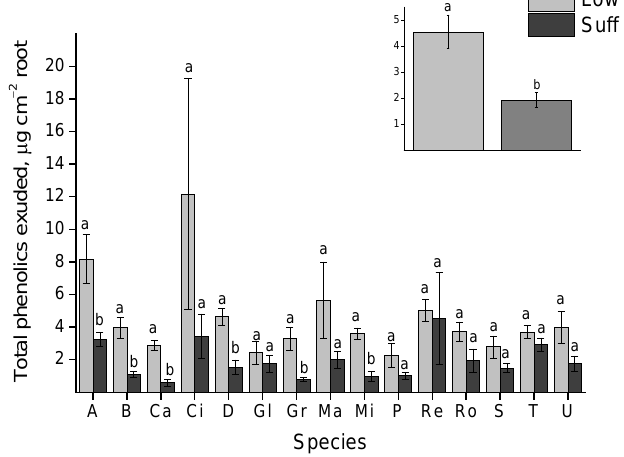
Figure 5. Total phenolics exuded by the roots of fifteen eucalypt species grown under low (Low P, clear color) and sufficient (Suff P, dark color) phosphorus concentrations. Different letters indicate significant differences between low and sufficient P concentrations within each species by the Tukey test ( p < 0.05). Species abbreviations: A— E. acmenoides , B— E. brassiana, Ca— E. camaldulensis , Ci— C. citriodora , D— E. deanei , Gl— E. globulus , Gr— E. grandis , Ma— C. maculata , Mi— E. microcorys , P— E. pellita , Re— E. resinifera , Ro— E. robusta , T— E. tereticornis , S— E. saligna , U— E. urophylla . Amino acids and polyamines were also analyzed in root exudates. Under low P, the amount of total amino acids and polyamines in the root exudates was two times the amount found at sufficient P (Figure 6). Similar to phenolics, a clear trend was observed for total amino acids and polyamines in the exudate of all species, i.e., most had more amino acids in plants grown in low P. Still, only a few were statistically significant ( E. brassiana , E. deanei , E. microcorys , E. robusta , E. saligna , and E. tereticornis ). E. tereticornis showed the greatest differences between low and sufficient P (Figure 6). When looking at the amino acid/polyamine profiles of the root exudates, the major compound identified in all 15 species was putrescine, followed by glycine (Figure 7). Curiously, E. urograndis plants under sufficient P showed reasonable amounts of putrescine, glutamine, and ly- sine, and much less glycine. In addition, for amino acids, we calculated the ratio between the contents found in low P and sufficient P plants (Table 2). The amino acid/polyamine profile was generally little changed in response to the P concentration. In general, putres- cine, agmatine, and glycine were the compounds with the highest increase in low P plants. On the contrary, lysine and glutamine were in a greater proportion in sufficient plants of E. microcorys , E. resinifera , and E. urograndis (Figure 7).